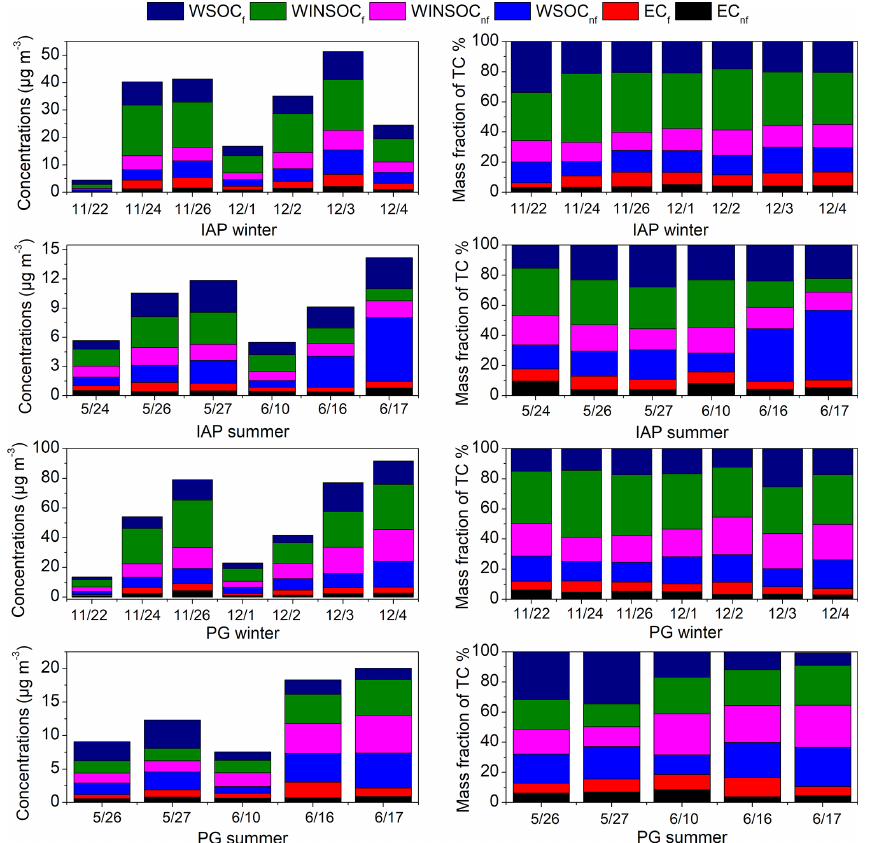
Figure 2. Time series of concentrations of WSOC f , WSOC nf , WINSOC f , WINSOC nf , EC f , and EC nf (left) and their relative contributions to TC (right) during winter in 2016 and summer in 2017 at IAP and PG. Table 3. Comparison of LG concentrations and OC from biomass burning in this study and related literature.